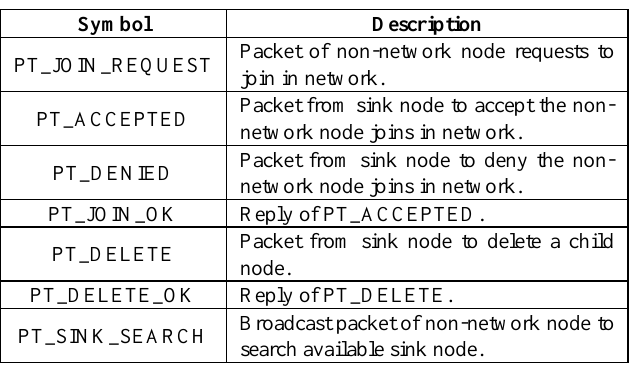
Table 1. Packet type definetion